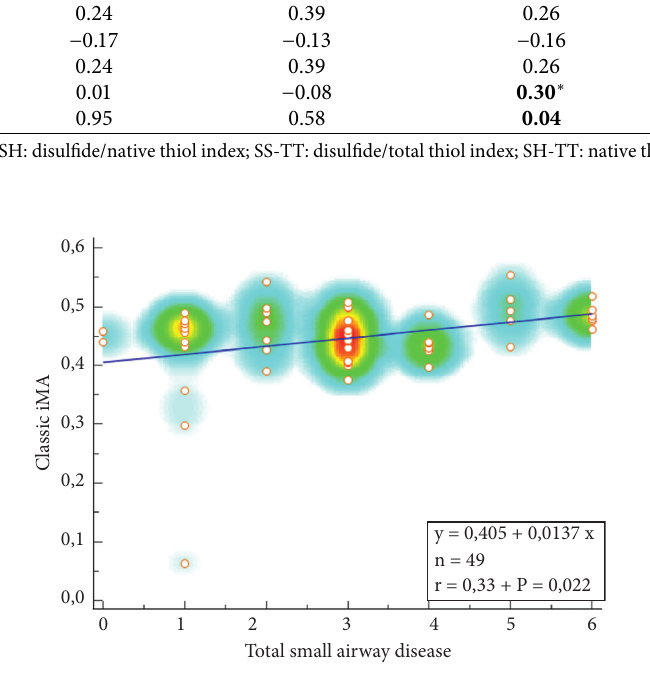
Figure 2: The correlation between the IMA levels in the blood and total small airway disease